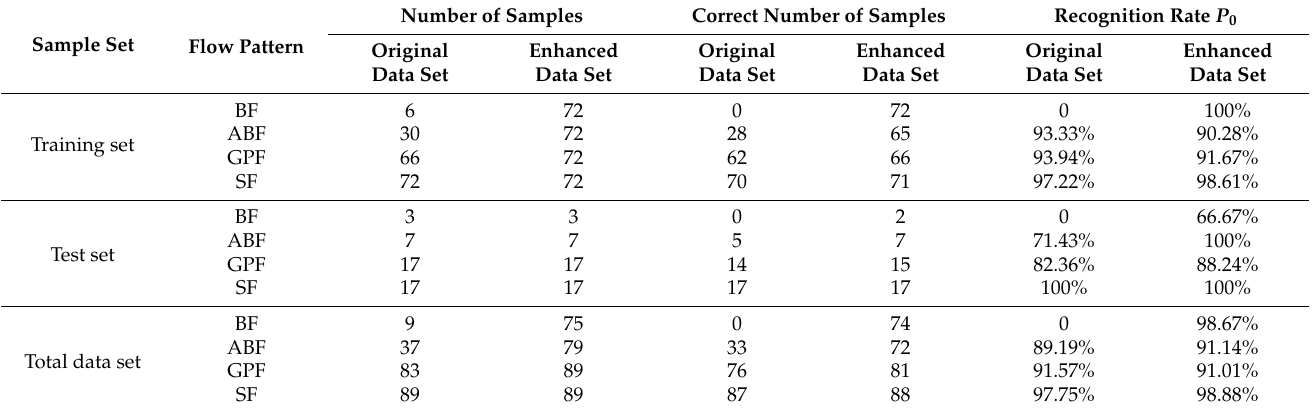
Table 7. Comparison of identification